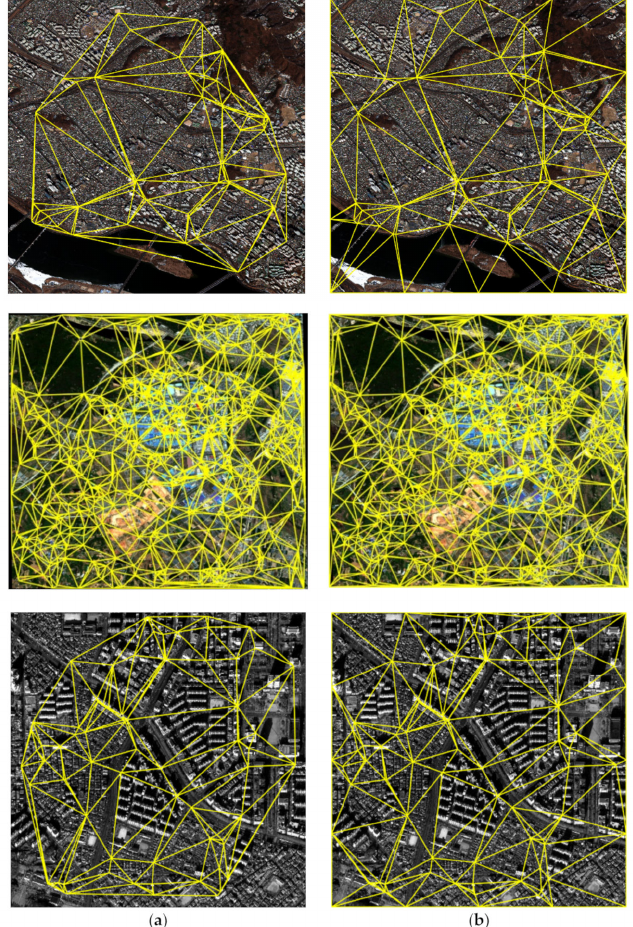
Figure 6. Construction of triangles using conjugate points (CPs) extracted using ( a ) piecewise linear (PL) transformation and ( b ) improved piecewise linear (IPL) transformation. First dataset (Seoul); second dataset (Gwangju); third dataset